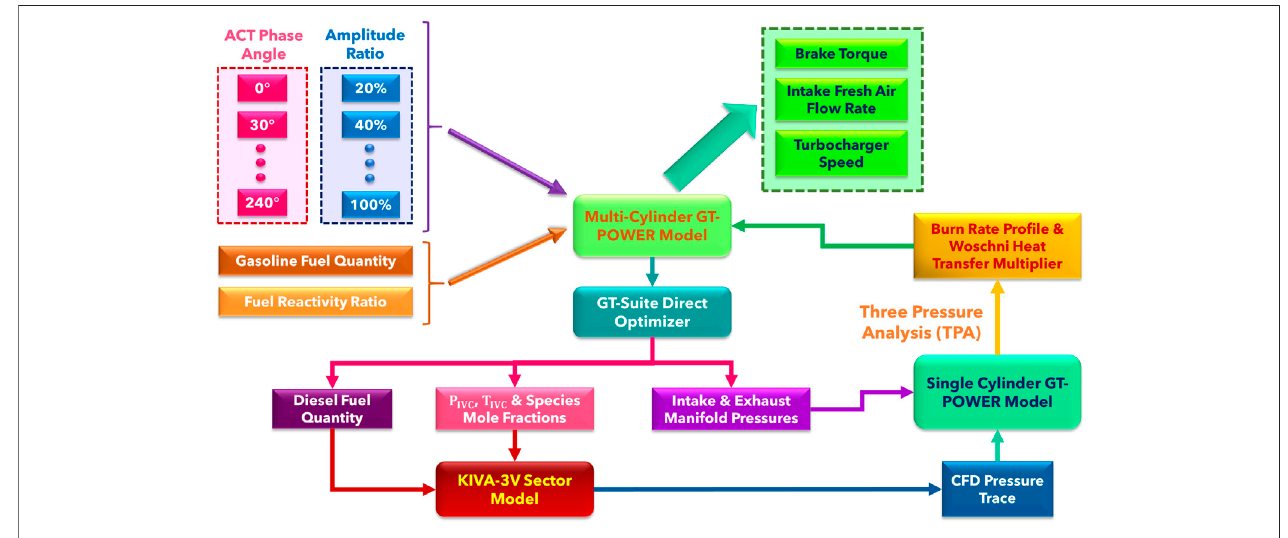
FIGURE 6 | Design of experiments simulation